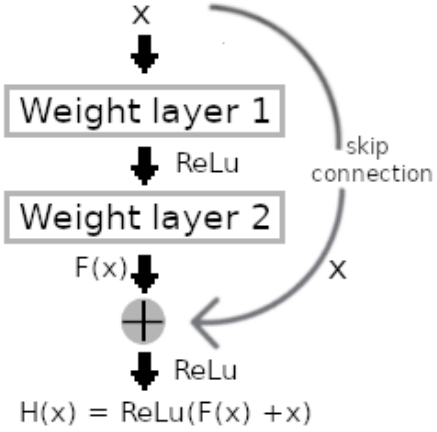
Figure 7. A 2-layer residual block with skip